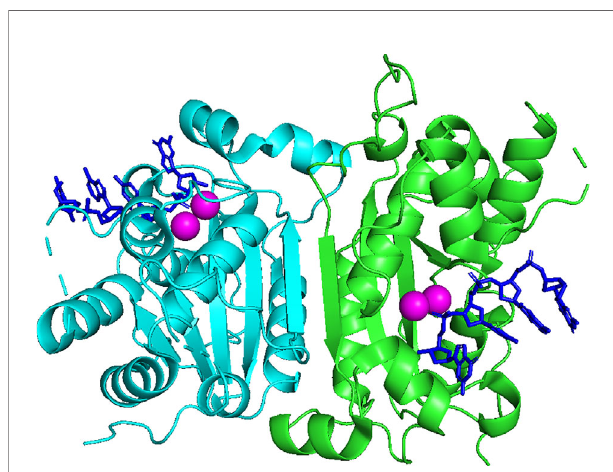
FIGURE 1 | Crystal Structure of the Dimeric Exonuclease mTREX1(1-242). Structure includes only the TREX1 catalytic domain (1-242). Protomers are distinguished by green and cyan, ssDNA by blue sticks, and calcium ions by magenta coloring. Crystal structure was visualized in PyMOL using the PDB structure 2OA8 from ref (6).